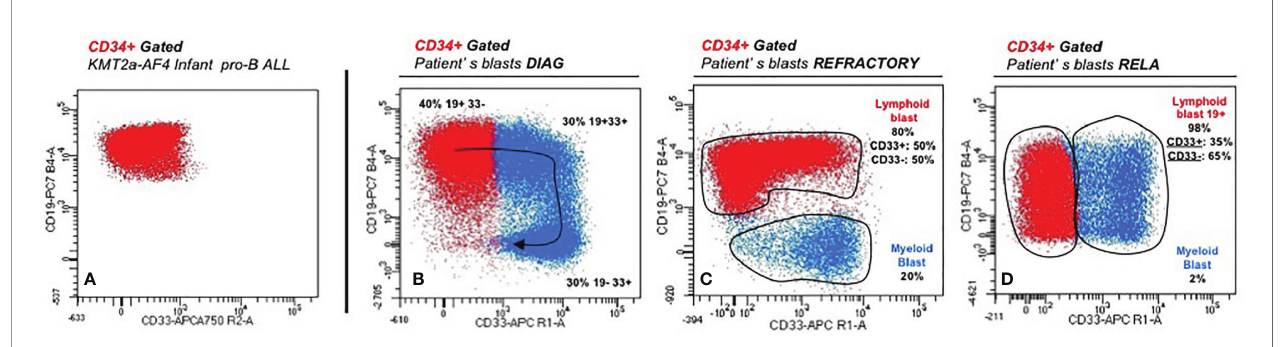
FIGURE 2 | Immunophenotyping features at diagnosis (A) , following courses (B, C) , and relapse